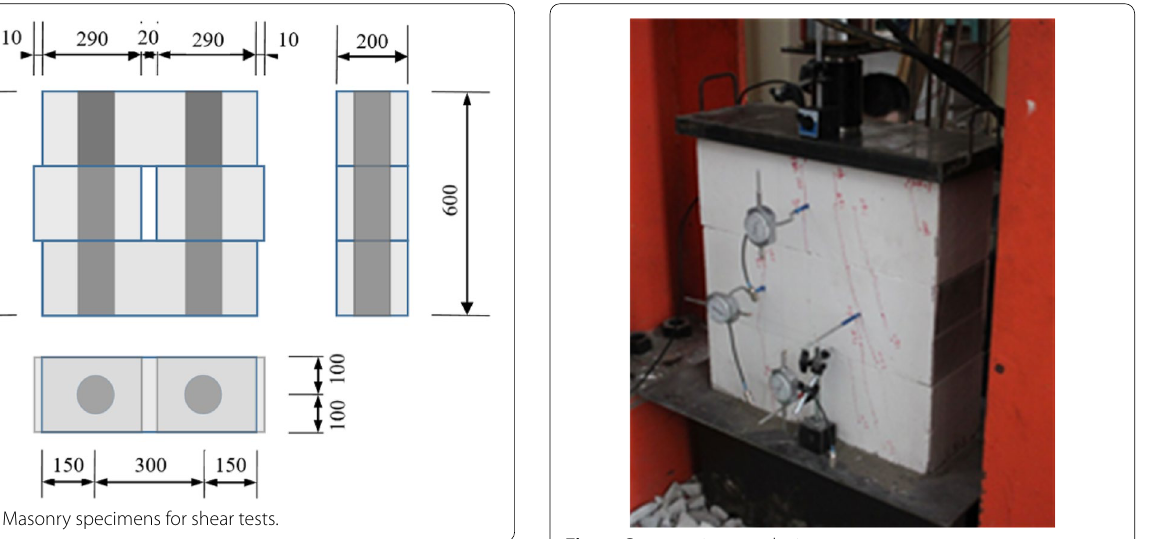
Fig. 5 Compression test device.